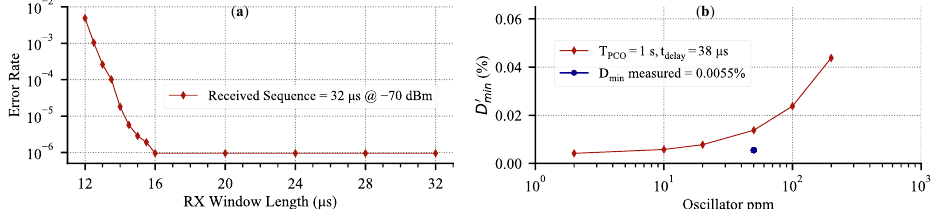
Figure 20. Error rate measurement for a two-node system at a fixed separation. ( a ) Syncword detection error rate vs. progressively reducing RX window for T PCO = 1 s. This is equivalent to moving RX On to the right until failure in Figure 11. The plot shows that for an insufficient RX window, the error rate rapidly increases. ( b ) The corresponding measured data overlay for Figure 14a.